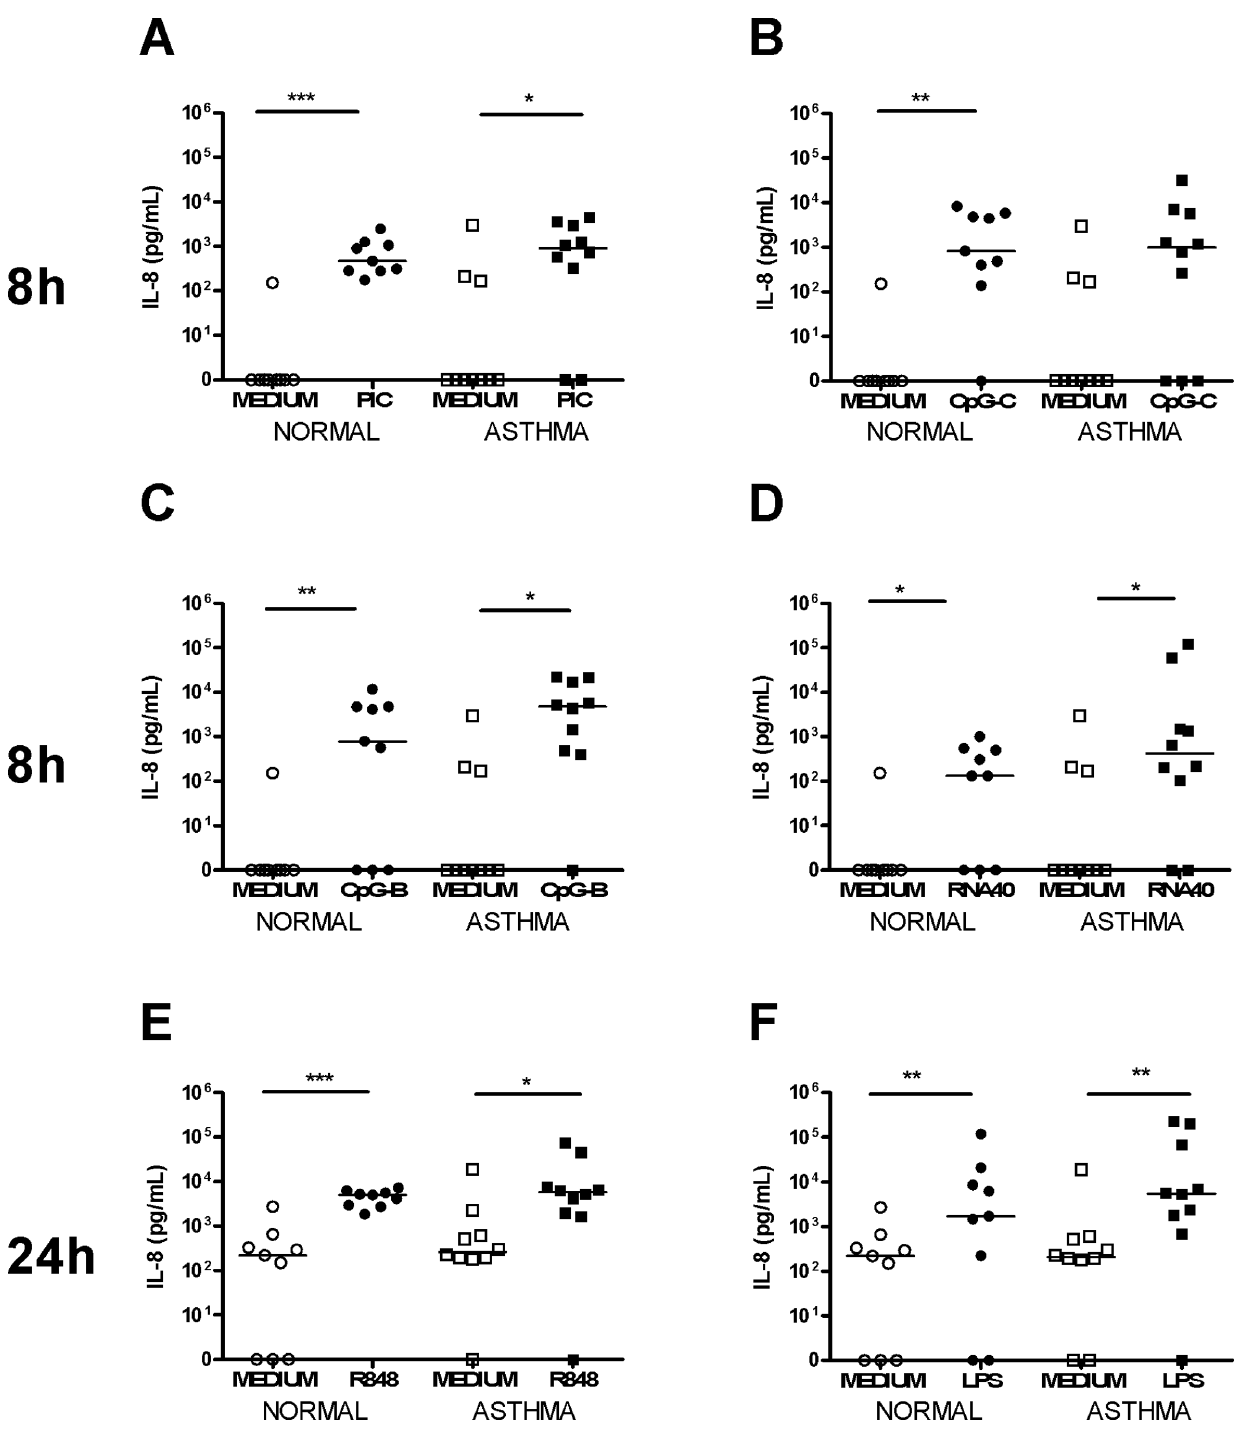
Figure 4. IL-8 induction following TLR stimulation in HBECs. Graphs depict IL-8 production at 8 h following stimulation with Poly I:C [A], CpG- C-ODN [B], CpG-B-ODN [C] and RNA40 [D] and at 24 h following R848 [E] and LPS [F]. Squares represent asthmatics, circles represent non-asthmatics. *=p , 0.05, **=p , 0.01, ***=p , 0.001.